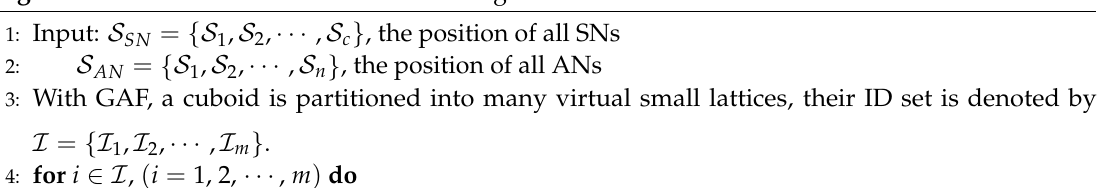
Algorithm 1 Virtual Lattice-Based Monitor